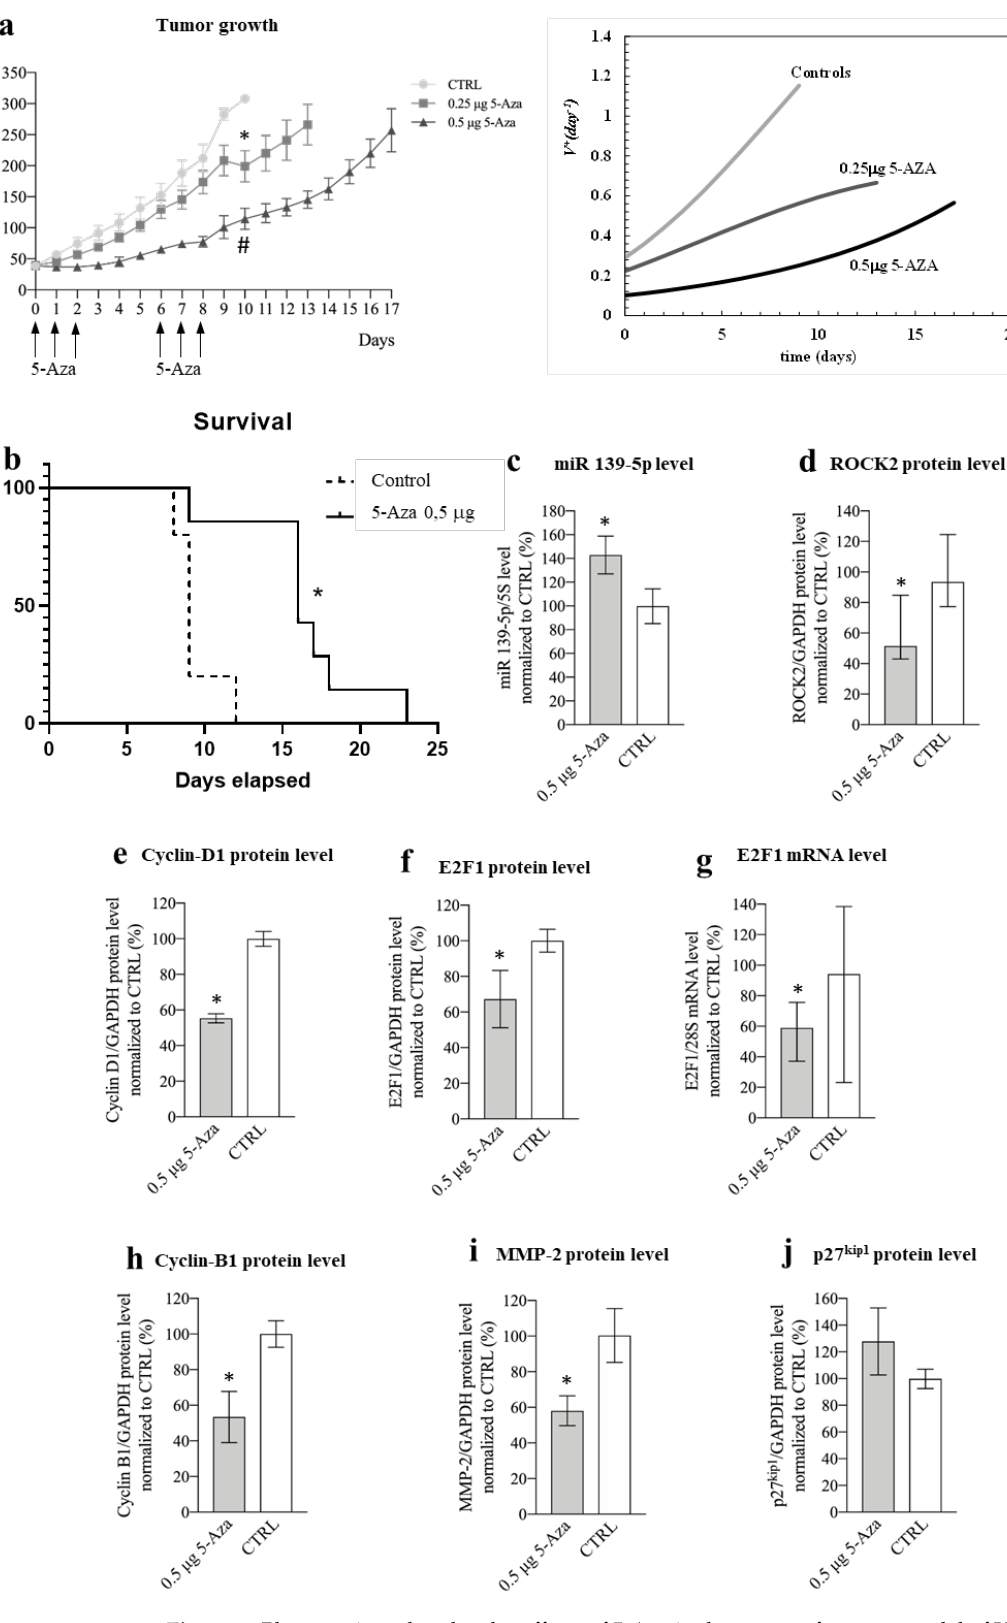
Figure 9. Phenotypic and molecular effects of 5-Aza in the xenograft mouse model of HCC. ( a ) Effects of 5-Aza on tumor growth. Left: the arrows indicate the administration times for 5-Aza (either 0.25 µ